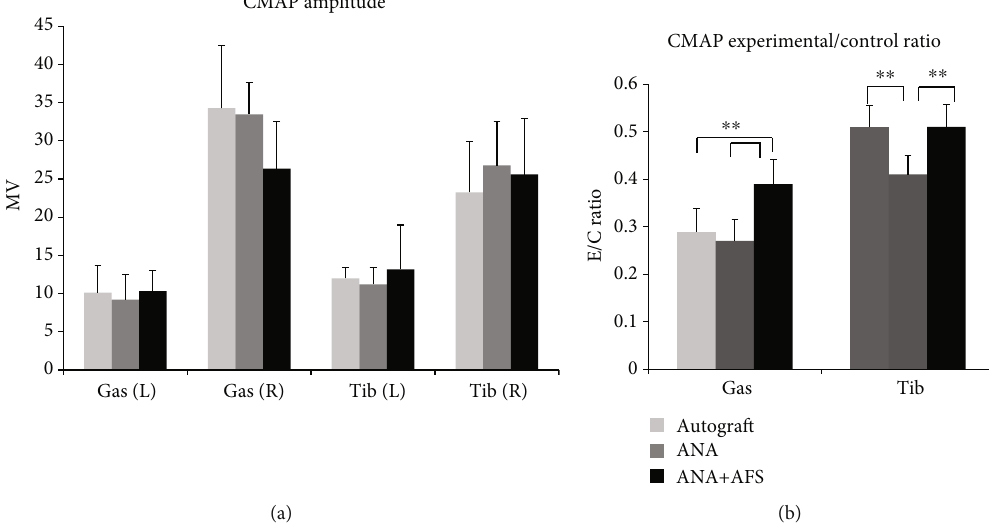
Figure 4: (a) Mean amplitudes of compound muscle action potential (CMAP) after stimulation of regenerating and contralateral control sciatic nerve with a monopolar electrode proximally. (b) Ratio of amplitude of experimental to contralateral CMAP of gastrocnemius and tibialis muscle in the ANA, ANA plus AFS, and autograft groups. ∗∗ p < 0 : 01